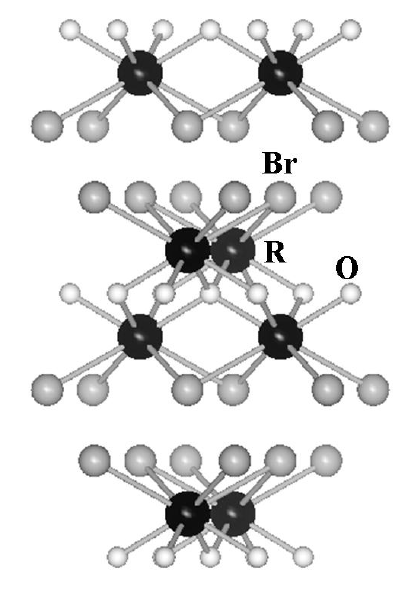
Figure 1. Crystal structure of the tetragonal PbFCl-type ROBr (R = rare